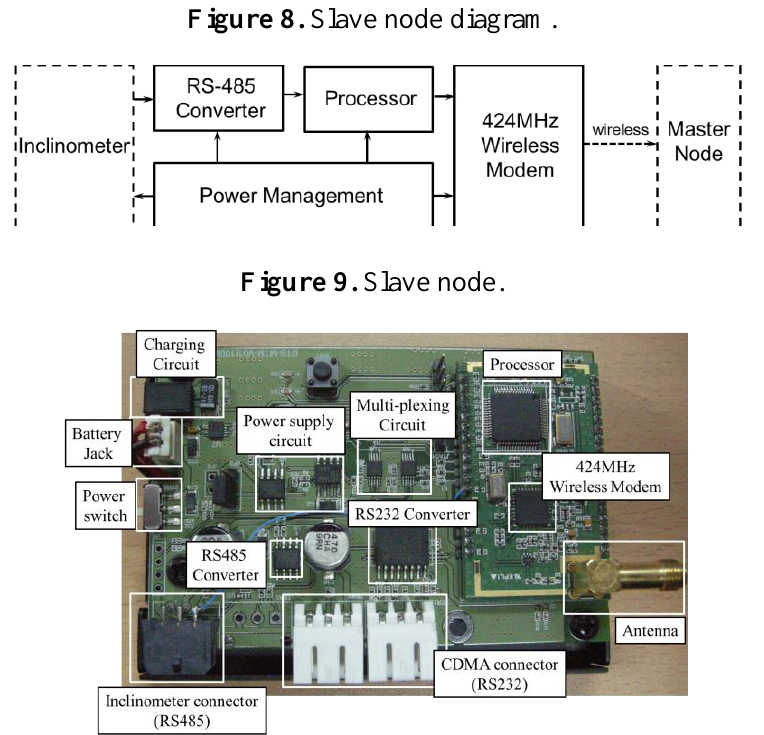
Figure 8. Slave node diagram.